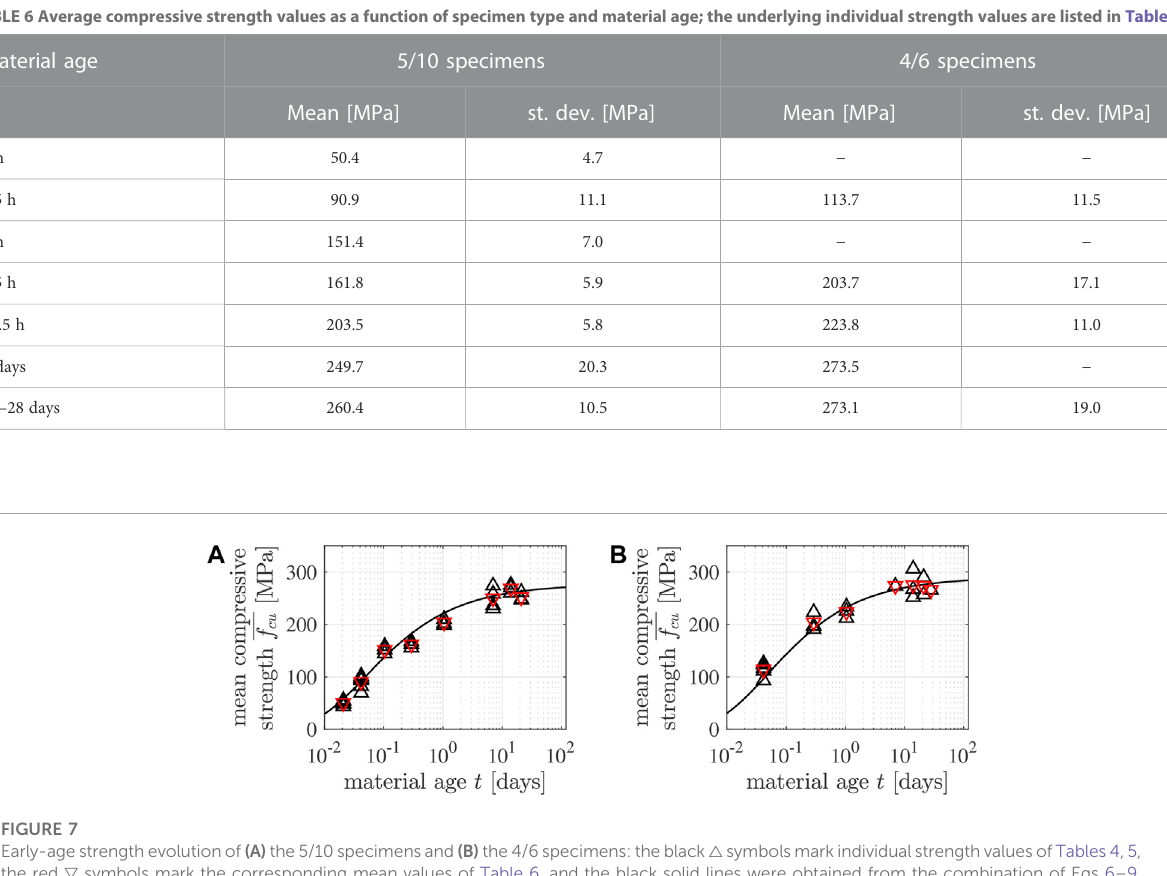
Frontiers in Bioengineering and